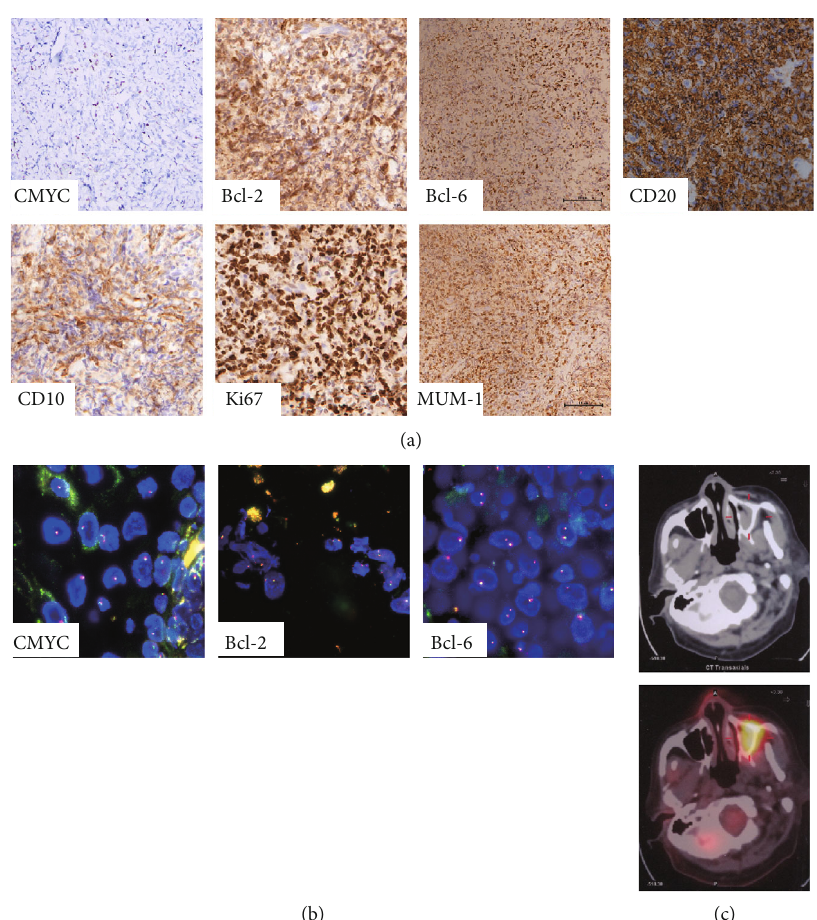
Figure 3: Immunohistochemical analysis showed that CD20, Bcl-2, Bcl-6, and MUM-1 were positively expressed. Ki-67 demonstrated a high (95%) proliferation rate, whereas CD10 and CMYC were negatively expressed (a). Fluorescence in situ hybridization (FISH) is negative for CMYC, Bcl-2, and Bcl-6 proto-oncogene rearrangements (b). Transverse PET-CT images showed about 2 : 8 × 3 : 3 cm hypermetabolic mass in the left maxillary sinus